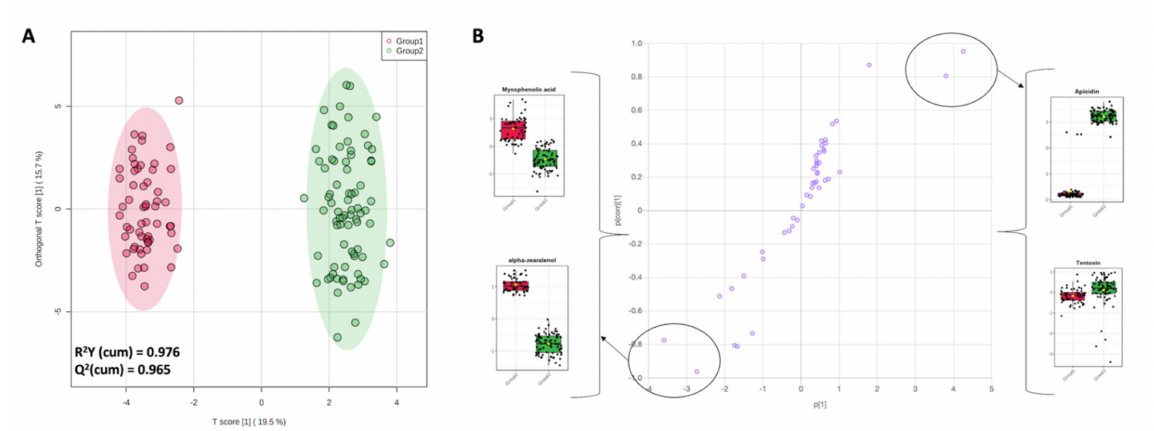
Figure 5. OPLS-DA score plot ( A ) considering the two group of milk samples outlined by the unsupervised k-means clustering approach, together with the S-plot; ( B ) outlining the most discriminant compounds for the comparison Group 1 vs. Group 2, namely mycophenolic acid and α -zearalenol (Group 1) followed by apicidin and tentoxin (Group